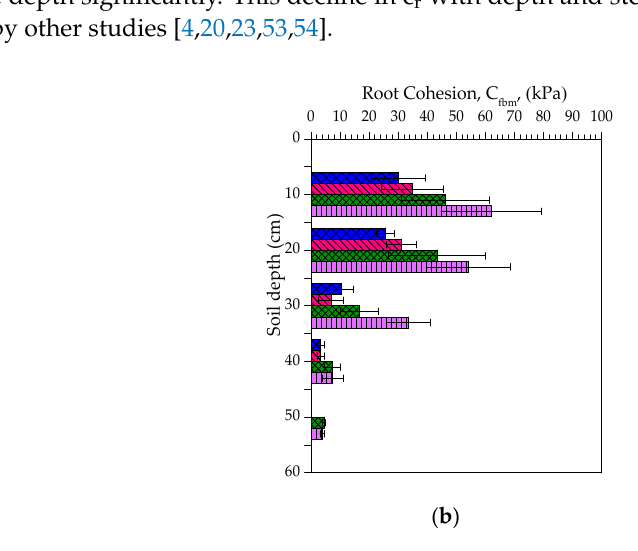
Figure 10. Variation of the root cohesion with depth ( a ) Wu and Waldron Model (WWM) (c r ) ( b ) Fiber Bundle Model (FBM)(c fbm ).